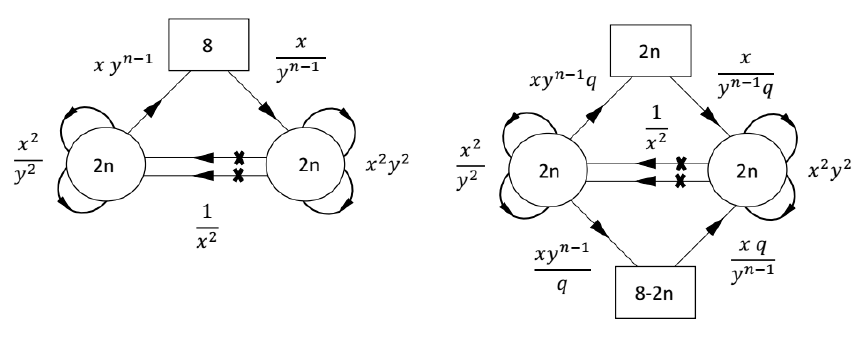
Figure 5. The 4 d theory conjectured to be the result of the compacti(cid:12)cation of the class of theories considered here on a torus with (cid:13)ux 1 in SU(2) E . Here again there is a cubic superpotential along the triangle and a quartic one coupling the two antisymmetrics via the bifundamentals. There are also two singlet chiral (cid:12)elds (cid:13)ipping the baryons made from the bifundamentals. The visible global symmetry here is SU(8) (cid:2) SU(2) (cid:2) U(1) x (cid:2) U(1) y where the SU(2) rotates the two antisymmetrics. From 6 d , it is expected that SU(8) ! E 7 and U(1) y ! SU(2). There is also a U(1) R R-symmetry under which the bifundamentals have R-charge 0, the (cid:13)ippers have R-charge 2, and the rest have R-charge